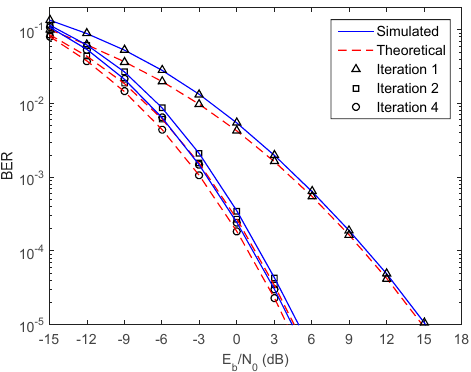
Figure 4. Performance of the proposed iterative hybrid equalizer and semi-analytic bit-error-rate (BER) approximation, with N RF rx = U = 8 and N rx = 32